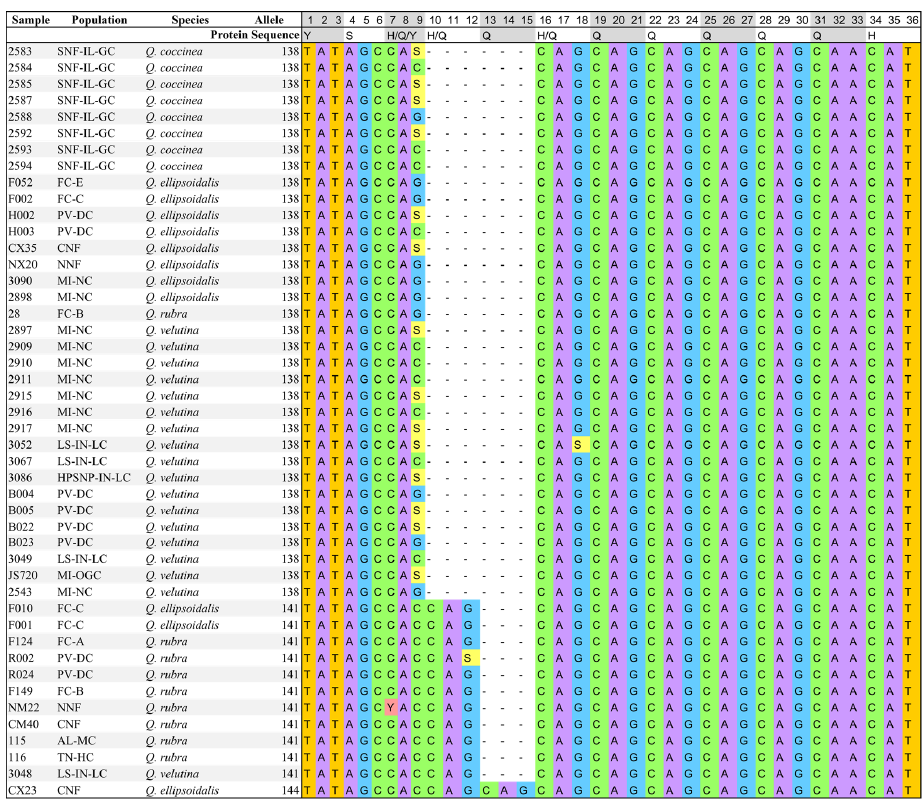
Figure 2. Sequence variation at the poly ‐ Q repeat in the COL gene in four red oak species (S = G or C; Y = C or T); codons alternately highlighted in medium grey and white.